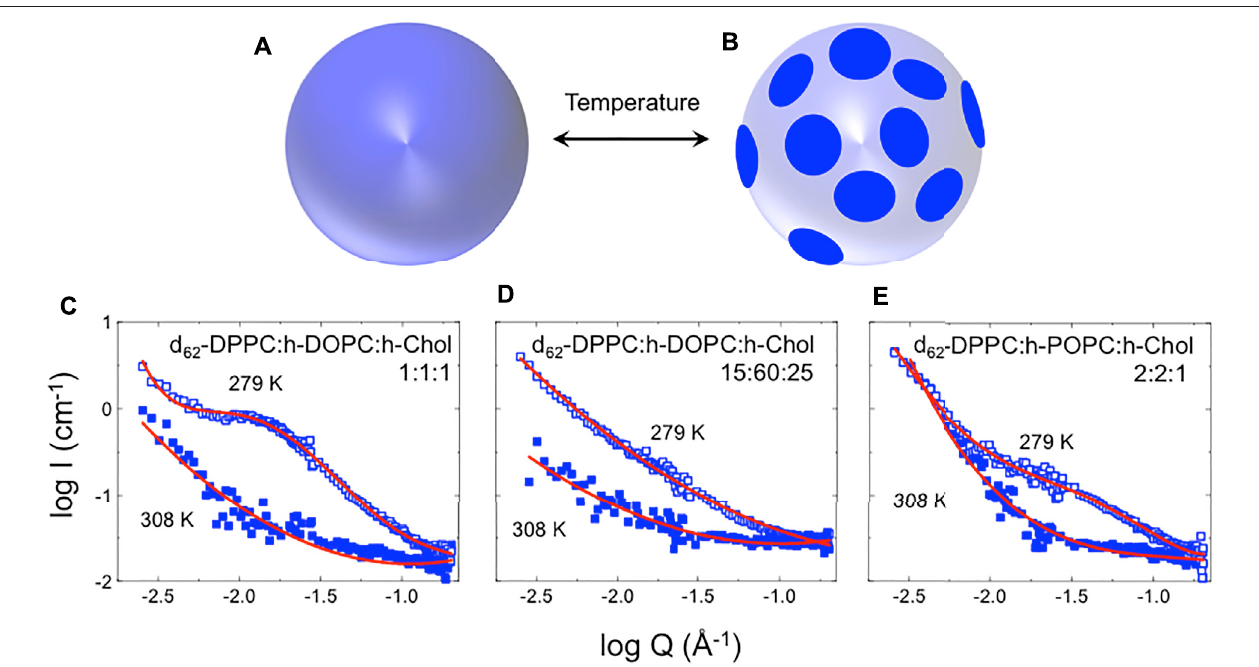
FIGURE 1 | (A,B) Schematic for the lipid raft formation. (C – E) SANS pro fi les at 279 (open symbols) and 308 K ( fi lled symbols) for: i) d 62 -DPPC:h-DOPC:h-Chol at molarratioof1:1:1 (C) and 15:60:25 (D) and d 62 -DPPC:h-POPC:h-Chol at molarratioof2:2:1 (E) .Inred isthebest fi tforthedatausing themethodology detailed inthe text. Pro fi les have been presented in log-log scale to highlight the raft domain, where